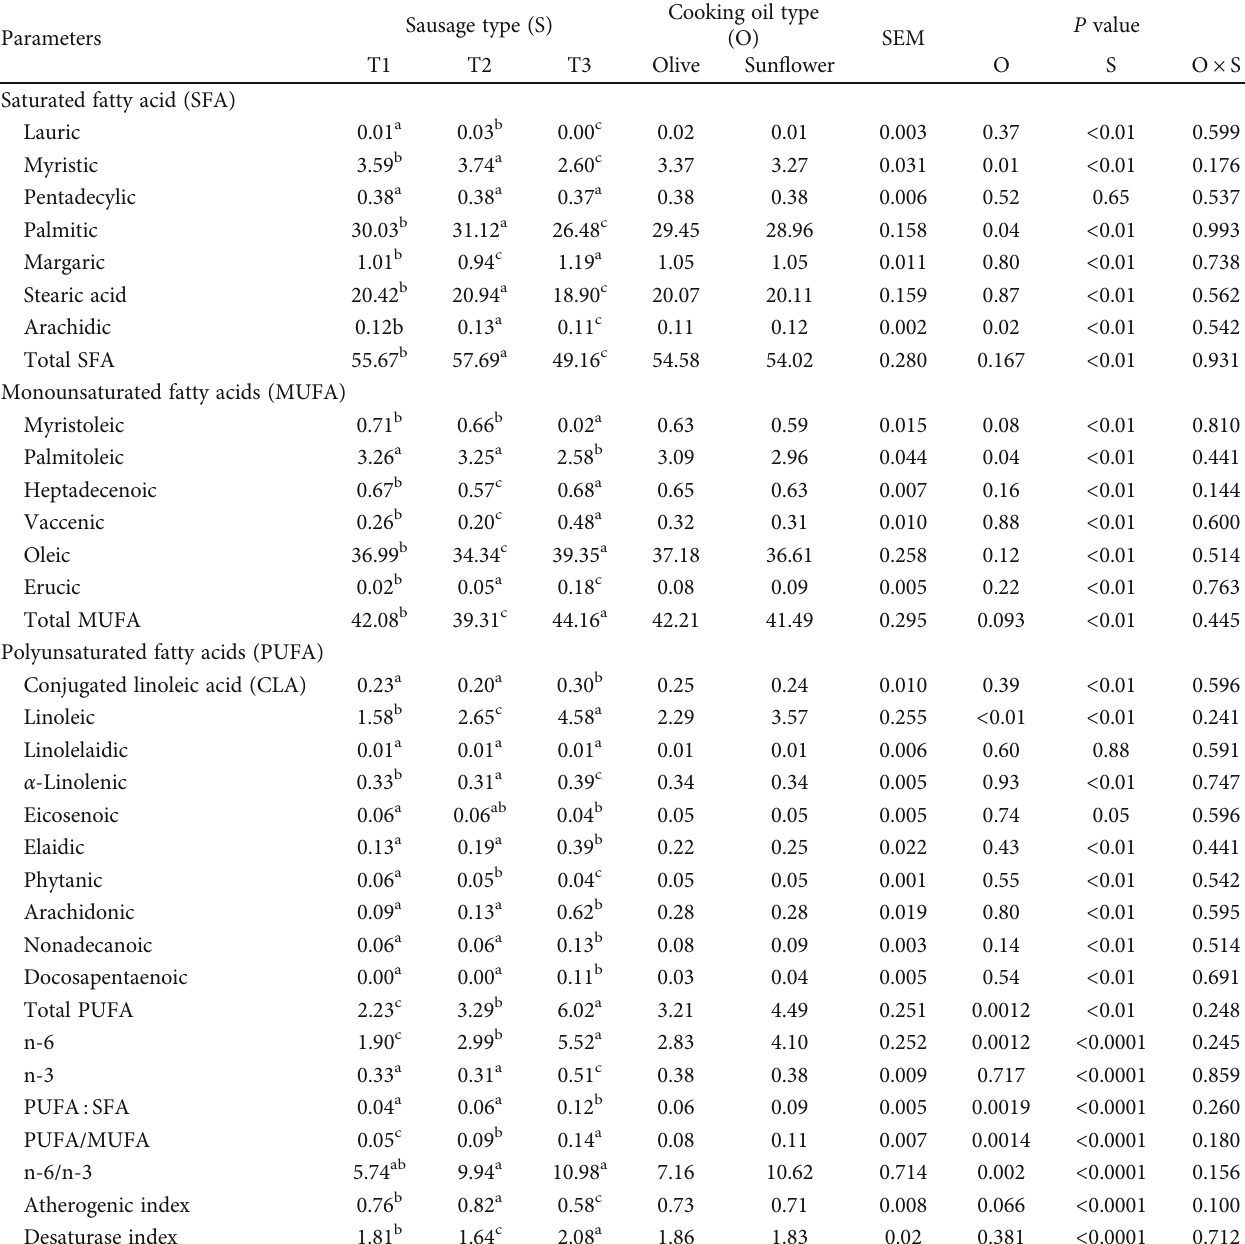
Table 4: E ff ect of the cooking oil type on fatty acid composition of the beef sausages forti fi ed with edible meat waste. Parameters